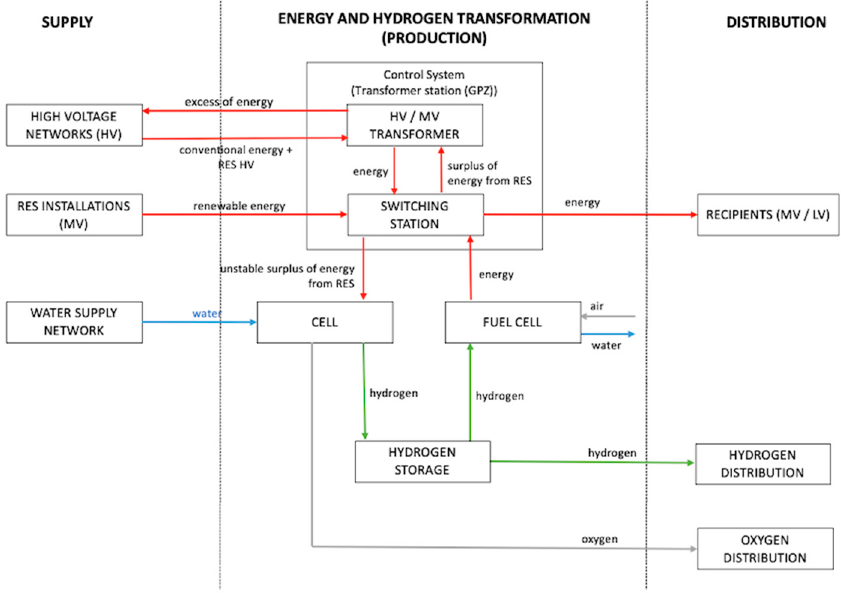
Figure 3. The concept of stabilizing the operation of power grids in the phase system of the supply chain. Source: own elaboration.